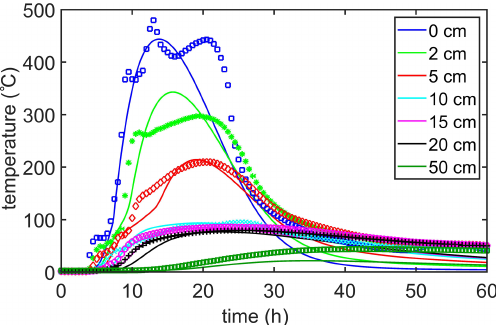
Figure 7. Soil surface energy balance components for the 26 April 2004 MEF burn resulting from the simplified surface en- ergy balance model (Eq. 18). The parameters for the forcing func- tion, Q F (t) or Eq. (15), are Q in = 0Wm − 2 , Q Fmax = 2.7kWm − 2 , t m = 9 . 5h and t d = 27 . 5h. Here the net forcing is the sum L ∗ G 0 because the surface sensible heat flux is not included as part the simplified surface energy balance.